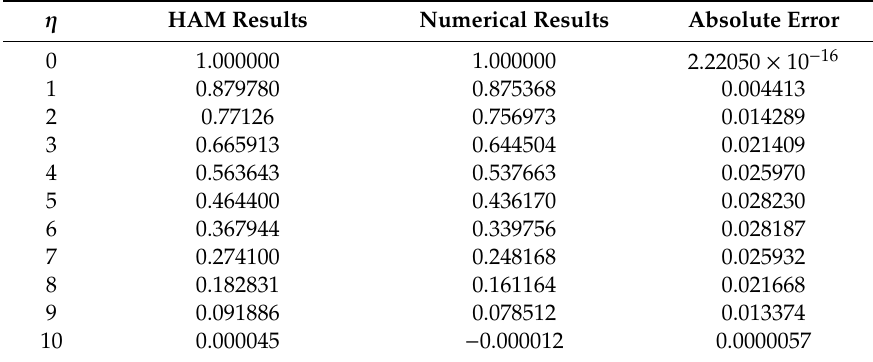
Table 4. Comparison results for platelet-shaped nanoparticles.